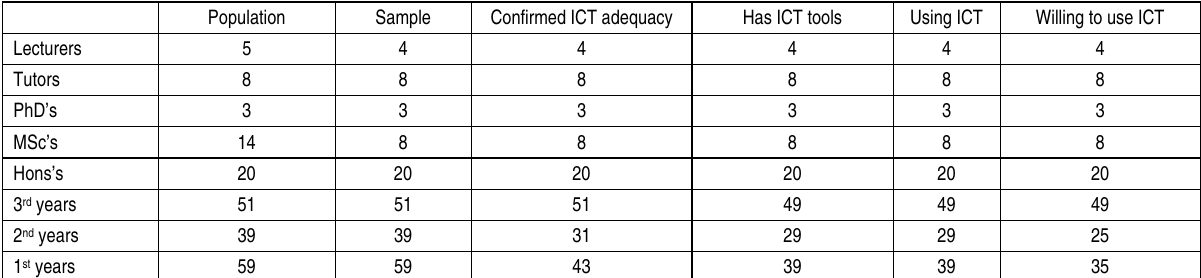
Table 1. People capacity and practice for SOR